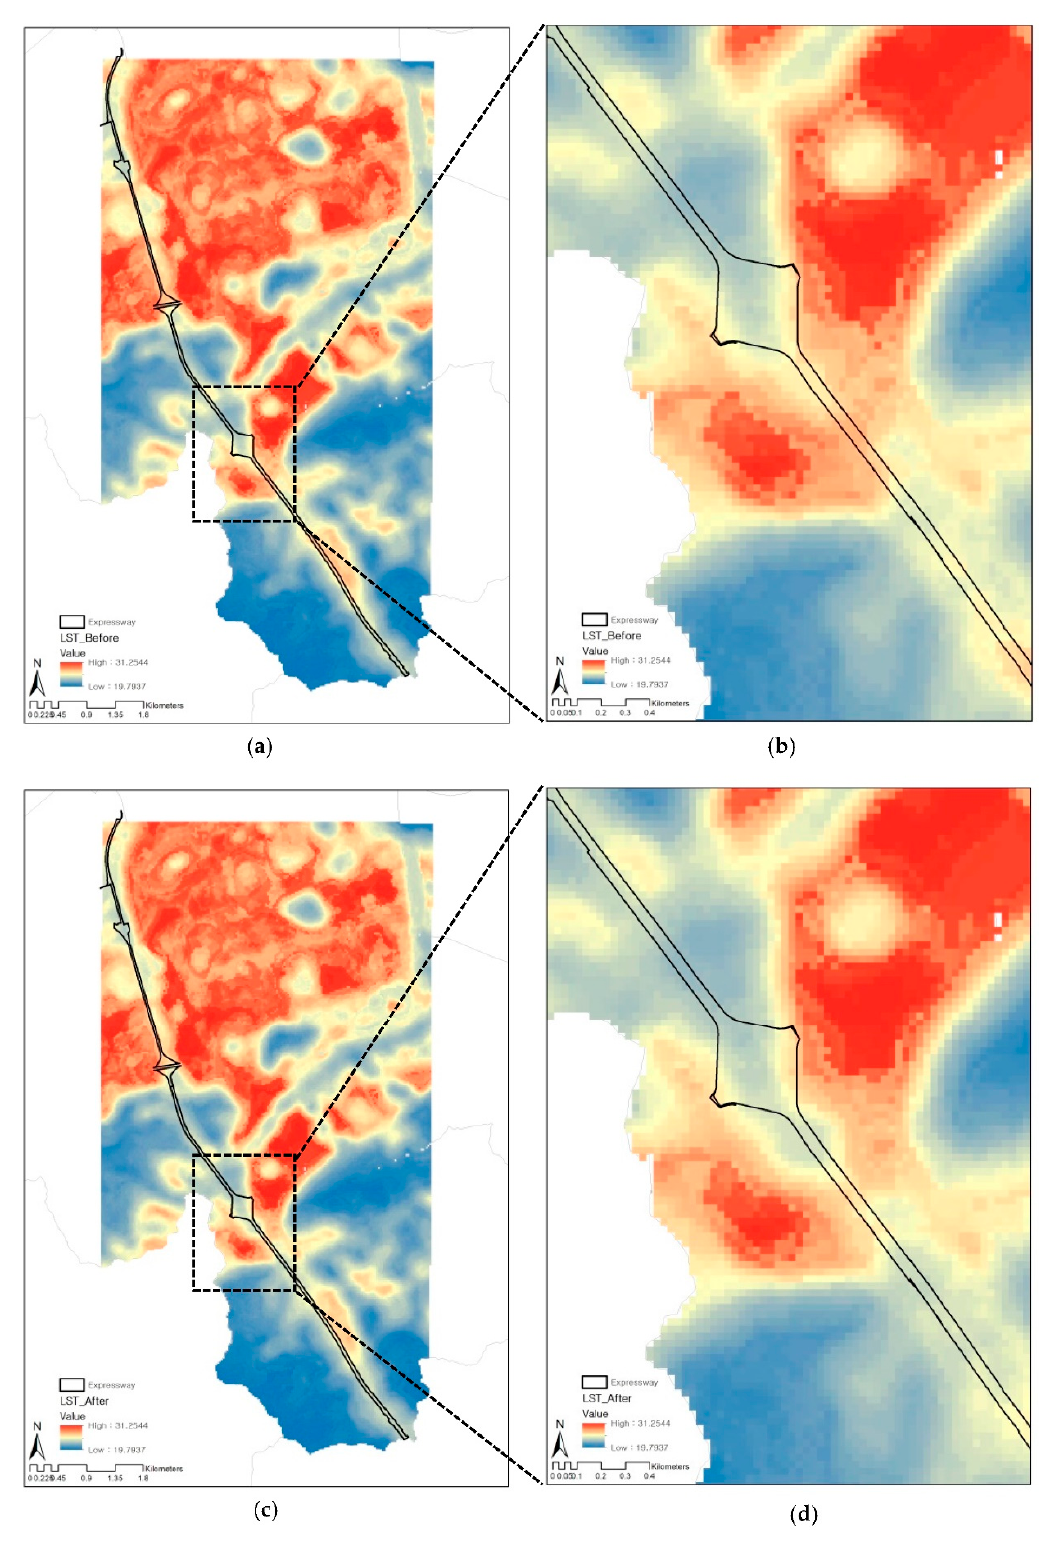
Figure 8. Prediction of LST before ( a , b ) and after ( c , d ) expressway underground project. As the distance from the expressway increases, the LST reduction effect was steadi- ly weakened. It is noteworthy that there is little effect on reducing LST by greening ex- pressway from a radius of 150 m or more. Similarly, the maximum LST reduction was 1.63 °C, and it was sharply decreased after 150 m away from the expressway. This trend